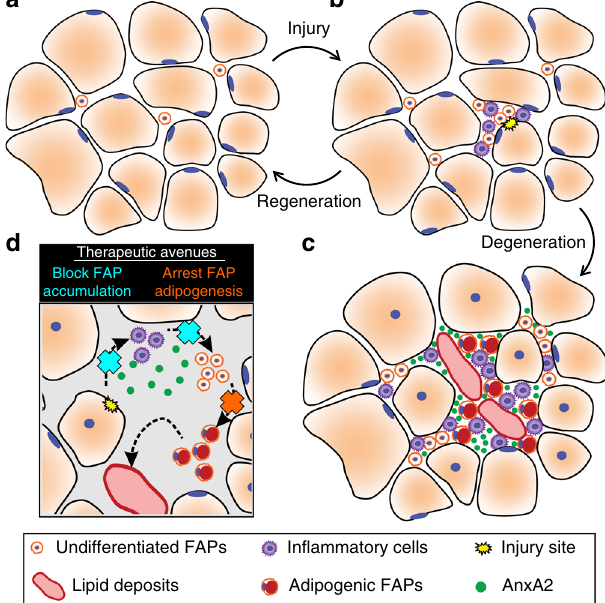
Fig. 8 FAPs control the onset and severity of disease in LGMD2B. a Healthy and/or pre-symptomatic LGMD2B muscle contains resident FAPs. b After myo fi ber injury, in fl ammatory cells invade and trigger FAP